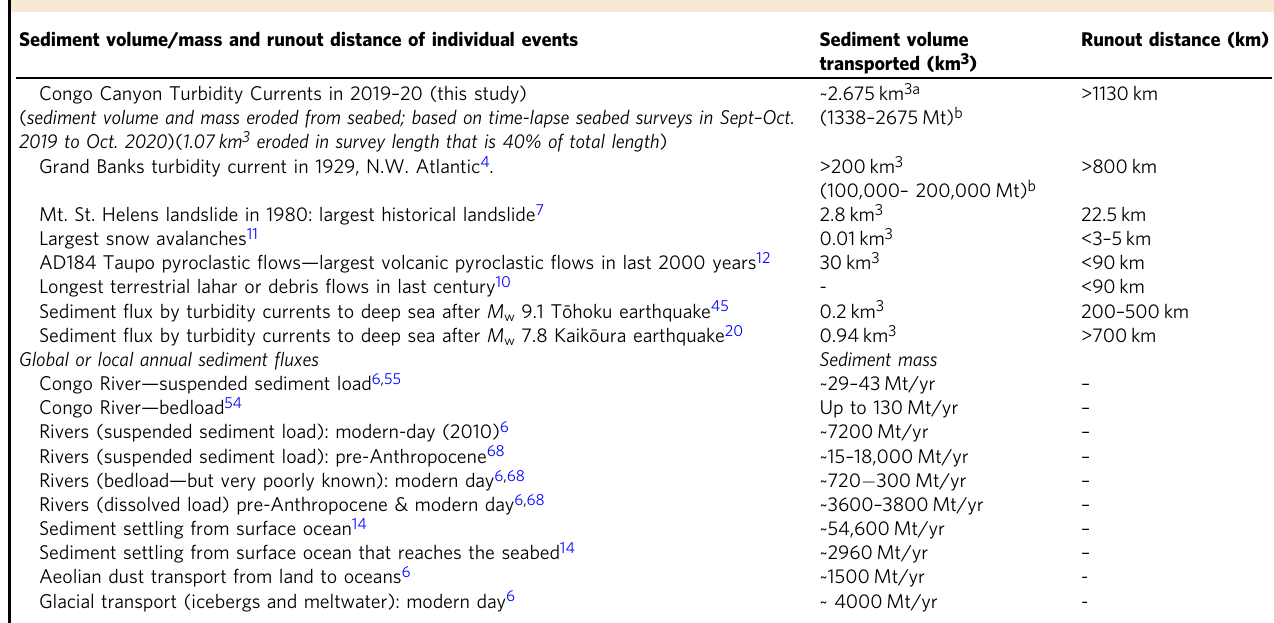
(Supplementary Table 1), including during coronavirus (CoV-19) related lockdown when internet bandwidth was particularly cri- tical. Understanding why these cables broke is important, espe- cially as they had not broken in the preceding 18 years (Supplementary Table 1). It has been proposed that turbidity current deposits (turbidites) can provide long-term records of other major hazards, including earthquakes, typhoons or river fl oods 26 – 28 . Such records are potentially valuable, as they extend further back in time than most records on land. This study provides detailed information on how long-runout turbidity currents are related to river fl oods, and how fl oods are recorded in the deep-sea.